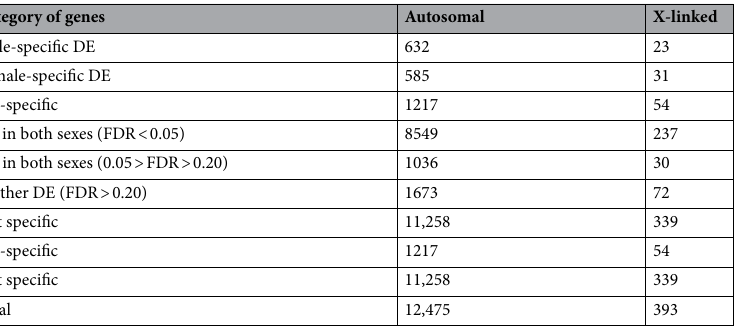
Table 1. Number of differentially expressed (DE) genes (FDR < 0.05) in response to LPS on the autosomes and the X chromosome. DE genes considered sex-specific were significant at FDR < 0.05 in the primary sex and not significant at FDR < 0.20 in the opposite sex. There was an enrichment of sex-specific responses to LPS among X-linked genes (54/393, 13.7%) compared to autosomal genes (1217/12,475, 9.8%) (Fisher’s Exact Test P =